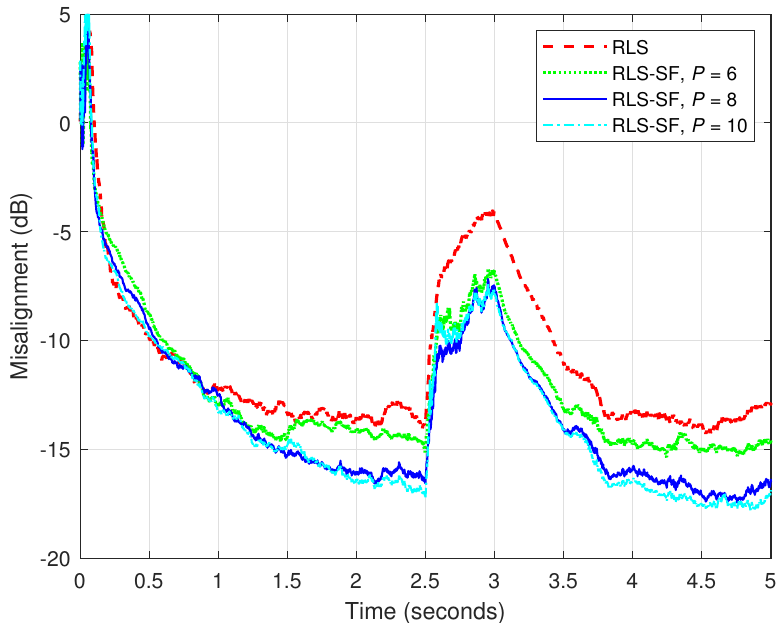
Figure 15. Performance of the conventional RLS filter [with λ = 1 − 1/ ( KL /2 ) ] and the RLS-SF [with λ 1 = 1 − 1/ ( 2 KPL 1 ) and λ 2 = 1 − 1/ ( 2 KPL 2 ) ], using K = 10, for the identification of the acoustic echo path from Figure 1c. The input signal is a speech sequence and the SNR decreases from 10 dB to 0 dB between times 2.5 and 3